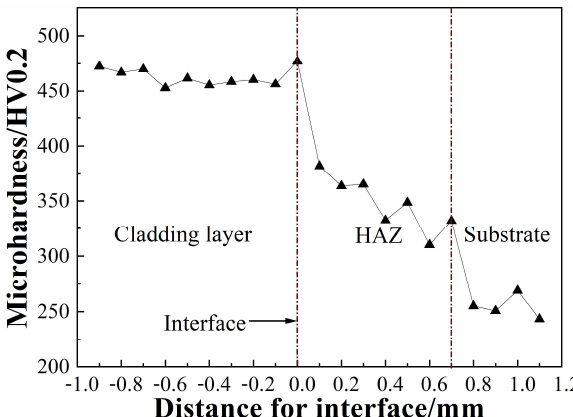
Figure 12. Microhardness distribution curve of repair sample.